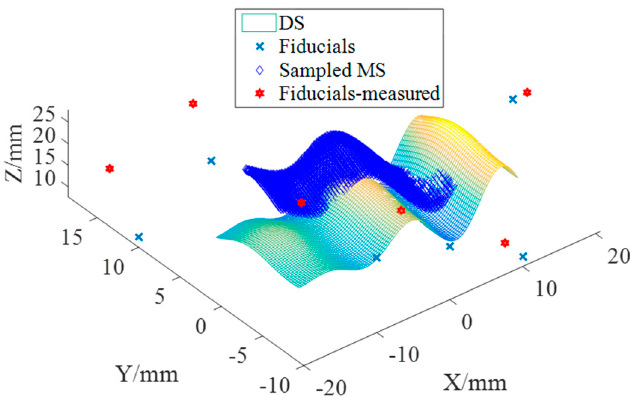
Figure 3. Simulated measured surface and designed surface with their fiducials. Figure 3 . Simulated measured surface and designed surface with their fiducials.